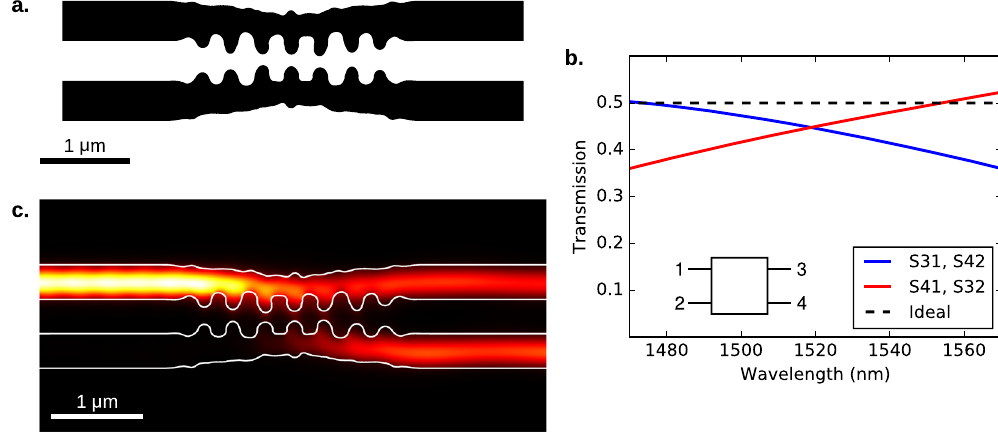
Figure 4. A relatively compact and broadband 50–50 directional coupler with 400 nm input and output waveguides. The device resembles a grating-assisted directional coupler. Here, we present ( a ) the final design, ( b ) simulated S-parameters, and ( c ) the electromagnetic energy density at 1550 nm.